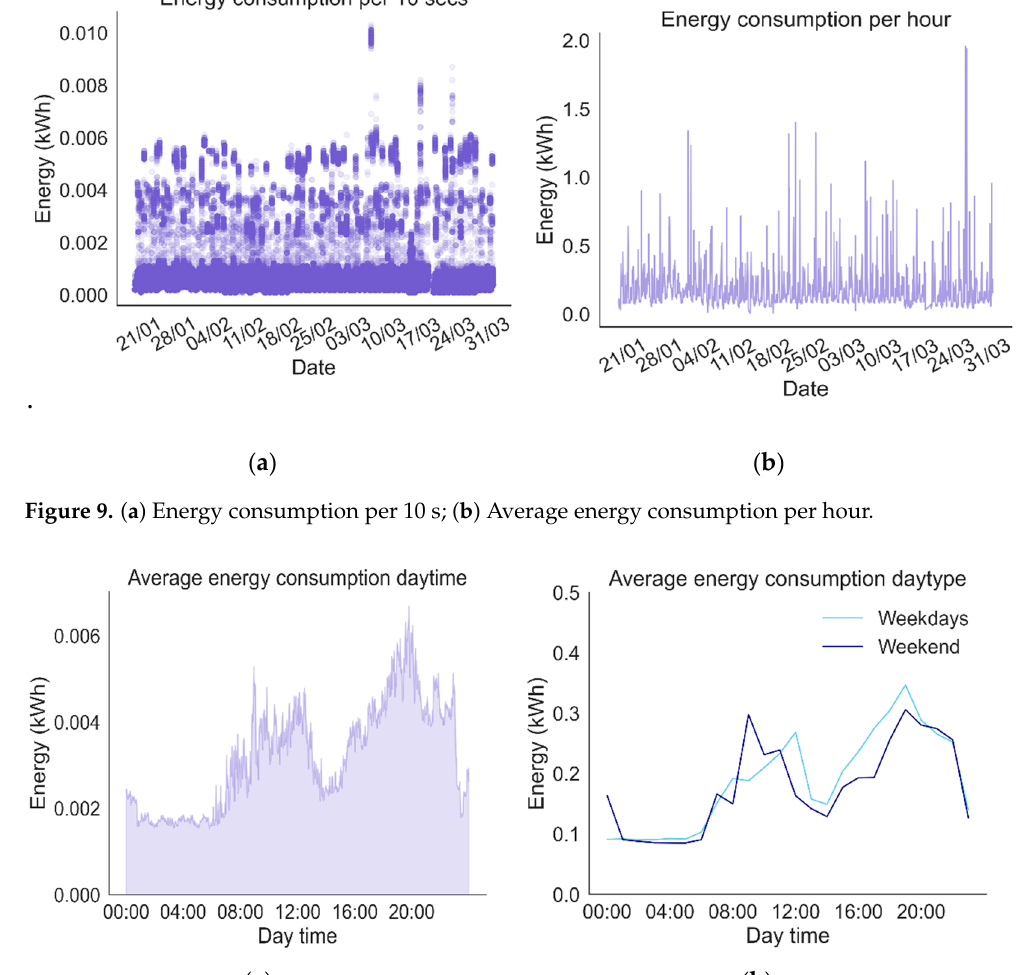
Figure 11. Average weekly energy distribution by days of week. ( a ) Percentage ‐ wise; ( b ) Con ‐ sumption ‐ wise.